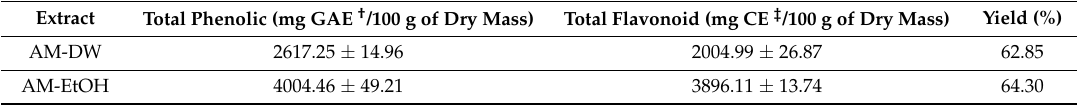
Table 2. Total phenolic and flavonoid content and yield of Aronia melanocarpa ‘Viking.’ Extract